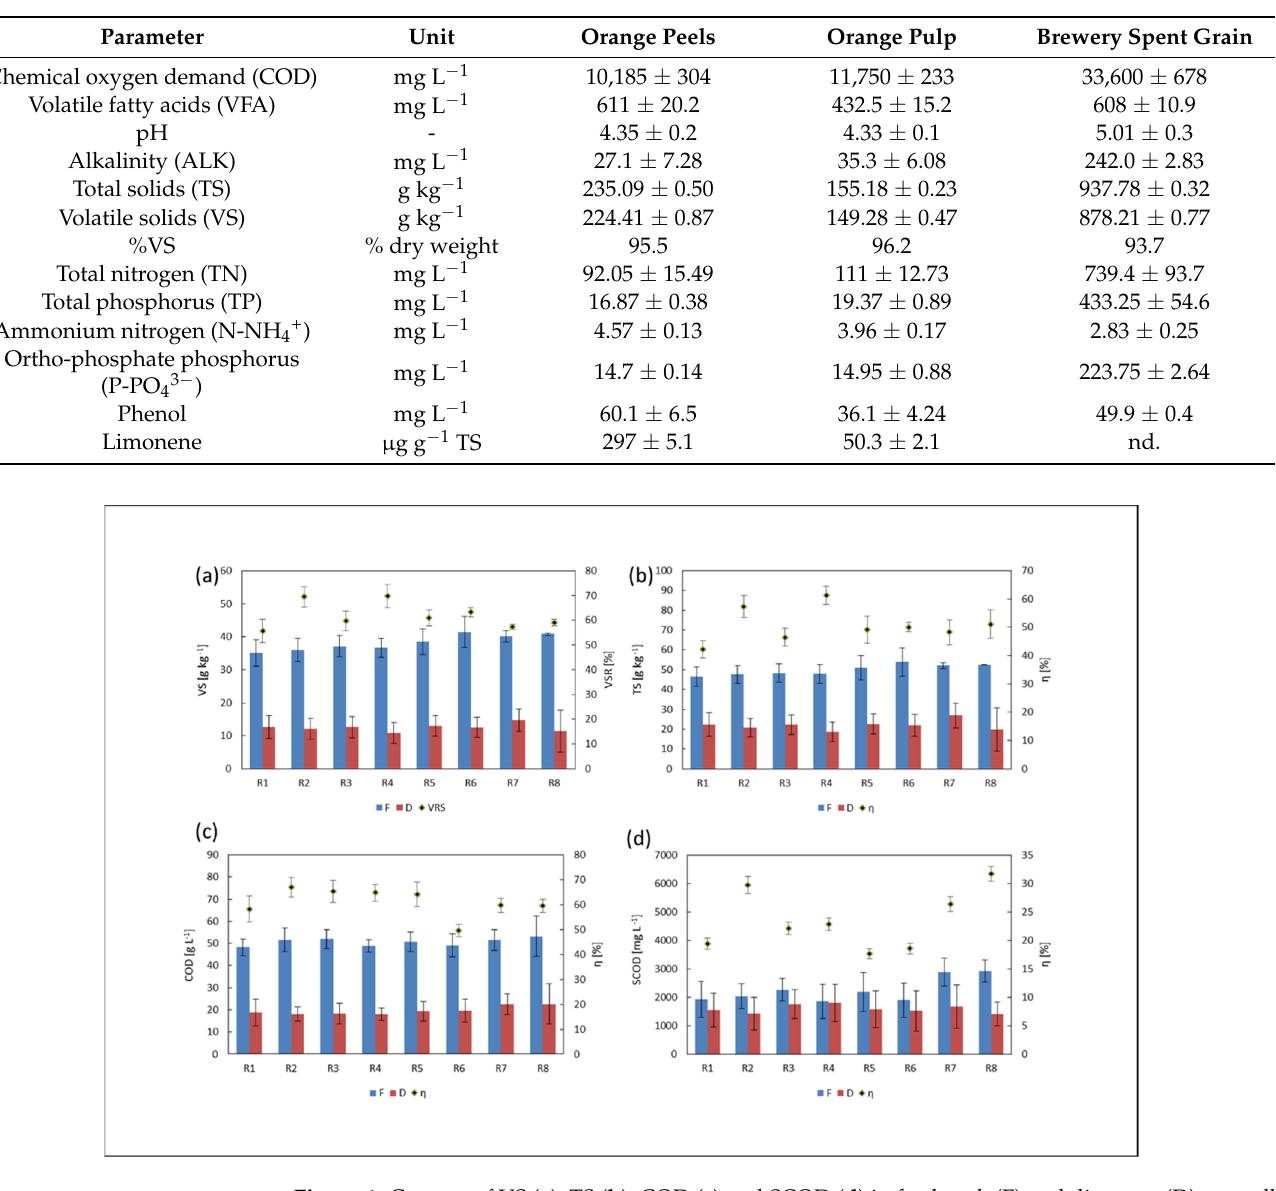
Table 2. Composition of the substrates used in the experiment (average values and standard deviation are given).